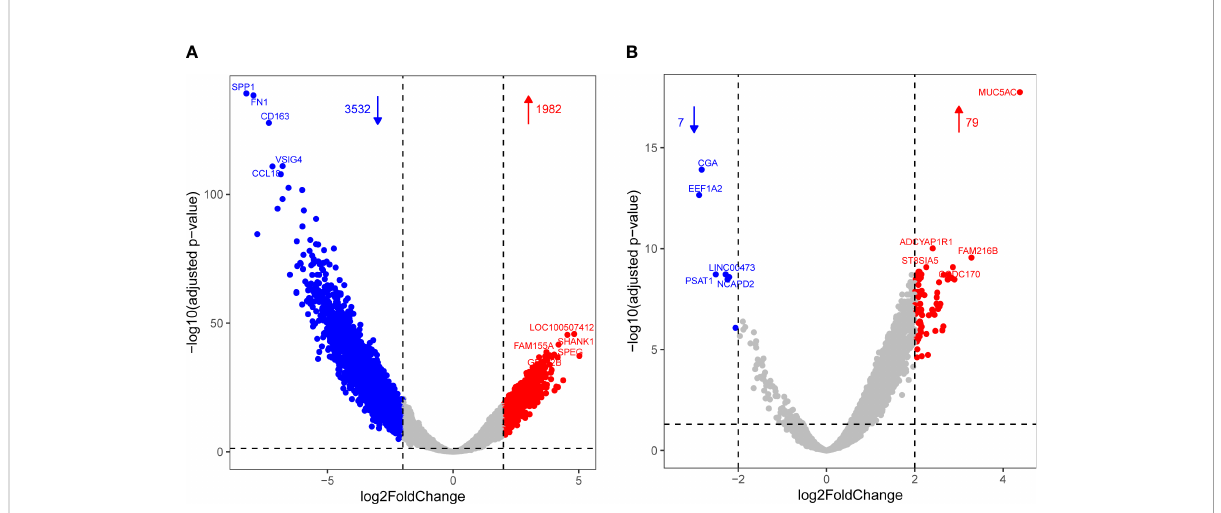
FIGURE 1 Volcano plot showing differential expression with increased DEGs colored in red and decreased DEGs colored in blue for comparisons of infected vs. other (A) and infected vs. recovered (B) groups,